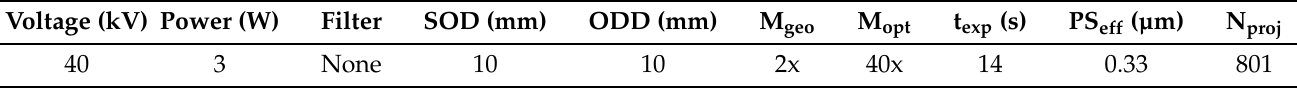
Table 2. Summary of XCT imaging parameters, including source–object distance (SOD),